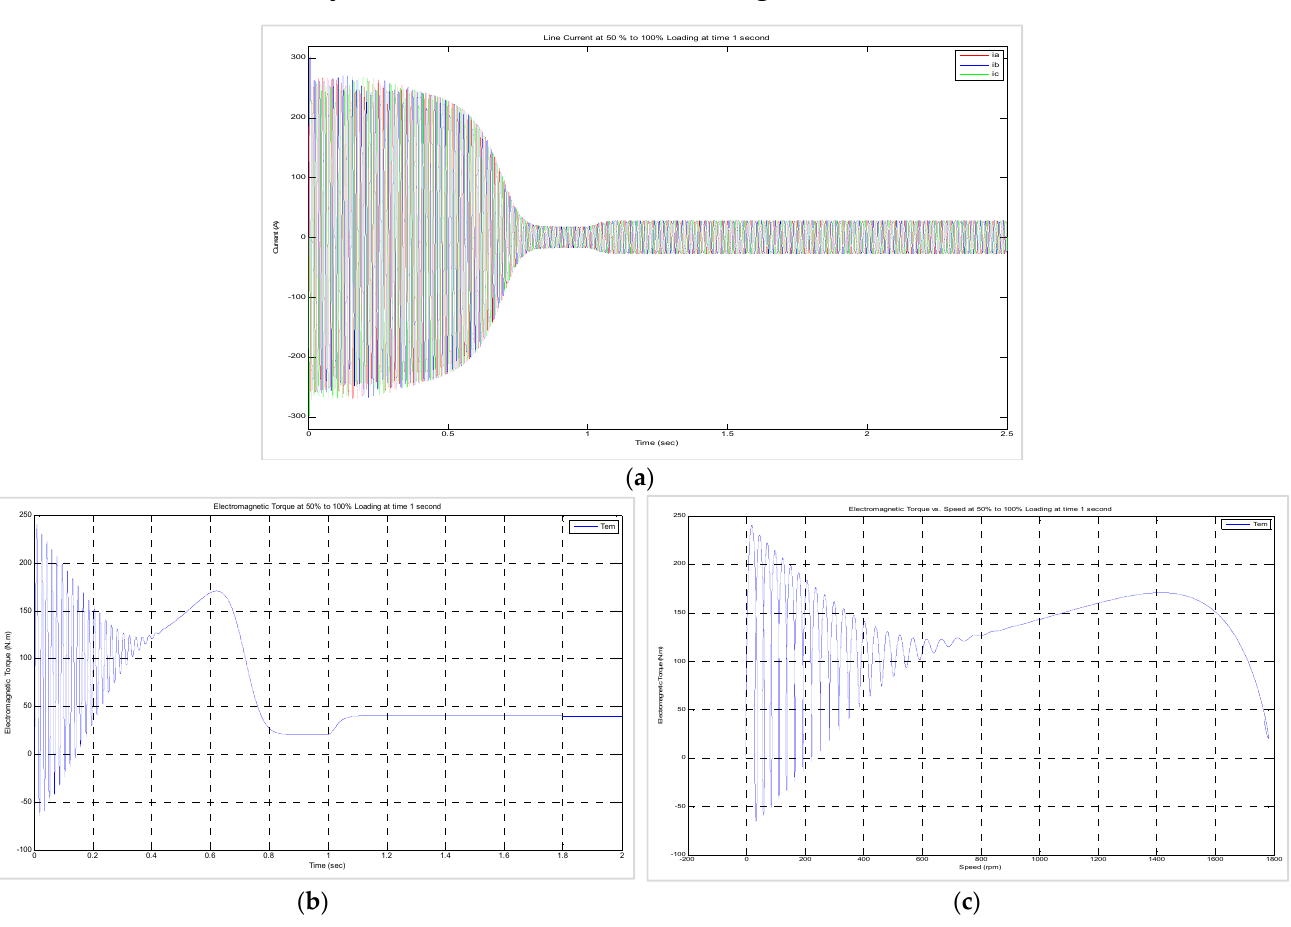
Figure 23. ( a ) Line current at 50% to 100% loading at 1 s. ( b ) Electromagnetic torque at 50% to 100% loading at 1 s. ( c ) Electromagnetic torque vs. speed at 50% to 100% loading at 1 s.